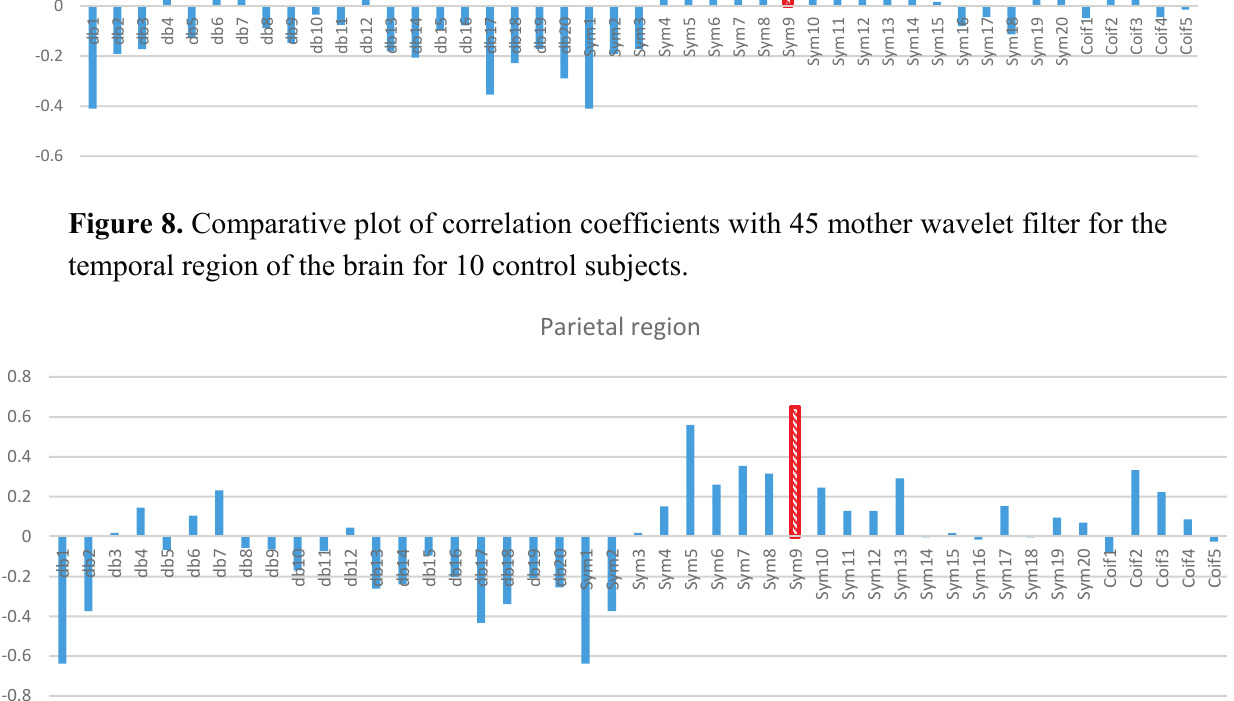
Figure 9. Comparative plot of correlation coefficients with 45 mother wavelet filter for the parietal region of the brain for 10 control